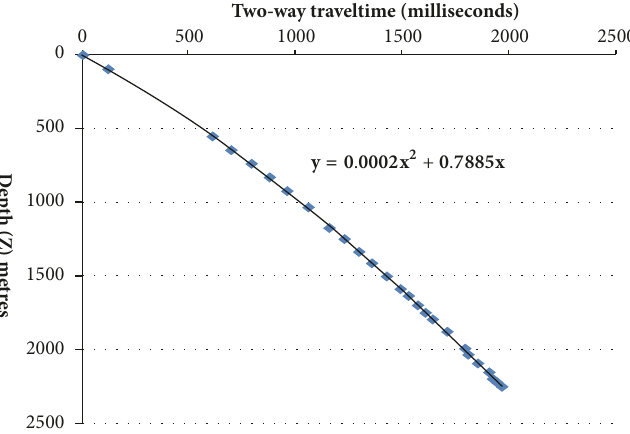
Figure 2: Polynomial plot (T-Z) showing the time to depth relationship, a curve generated using checkshots from wells.